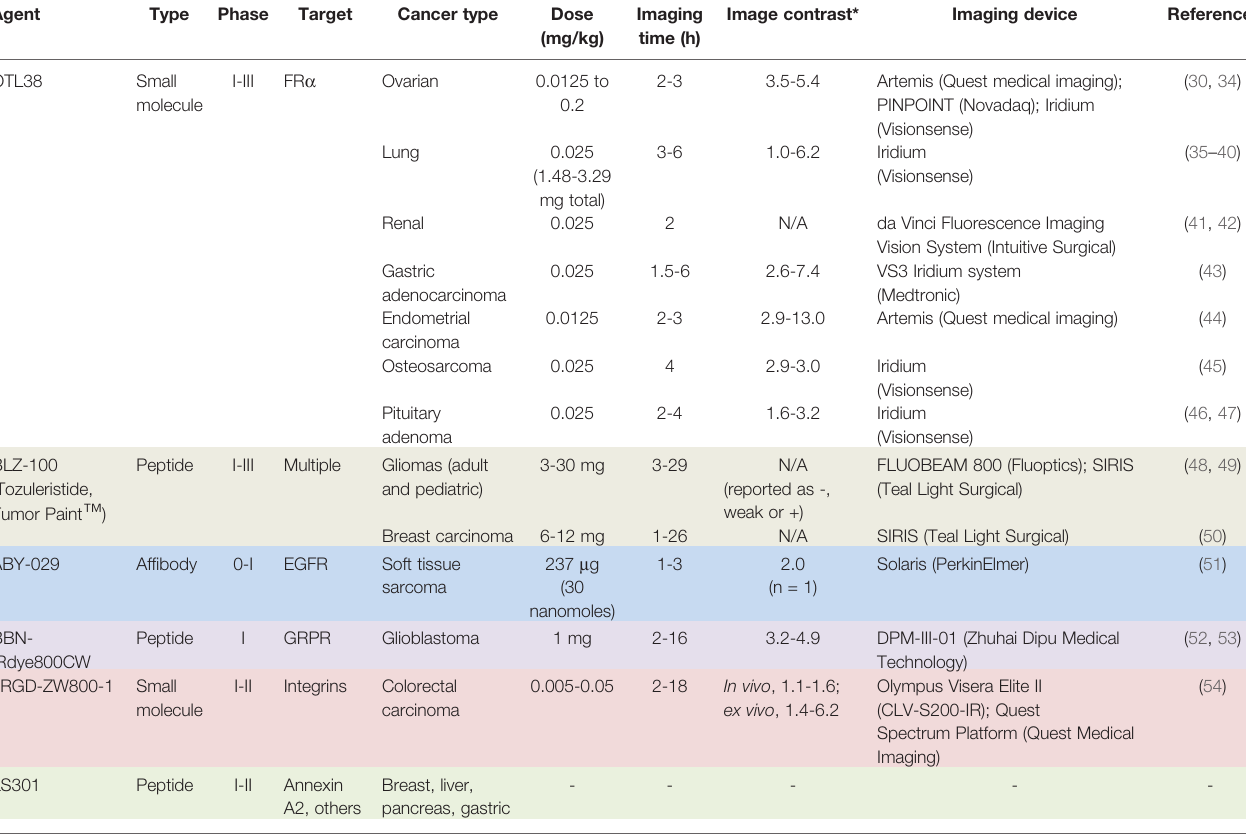
TABLE 1 | Summary of key parameters in clinical studies with LMW contrast